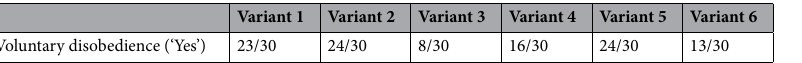
Table 2. Number of volunteers who reported that they voluntarily disobeyed the orders of the experimenter.